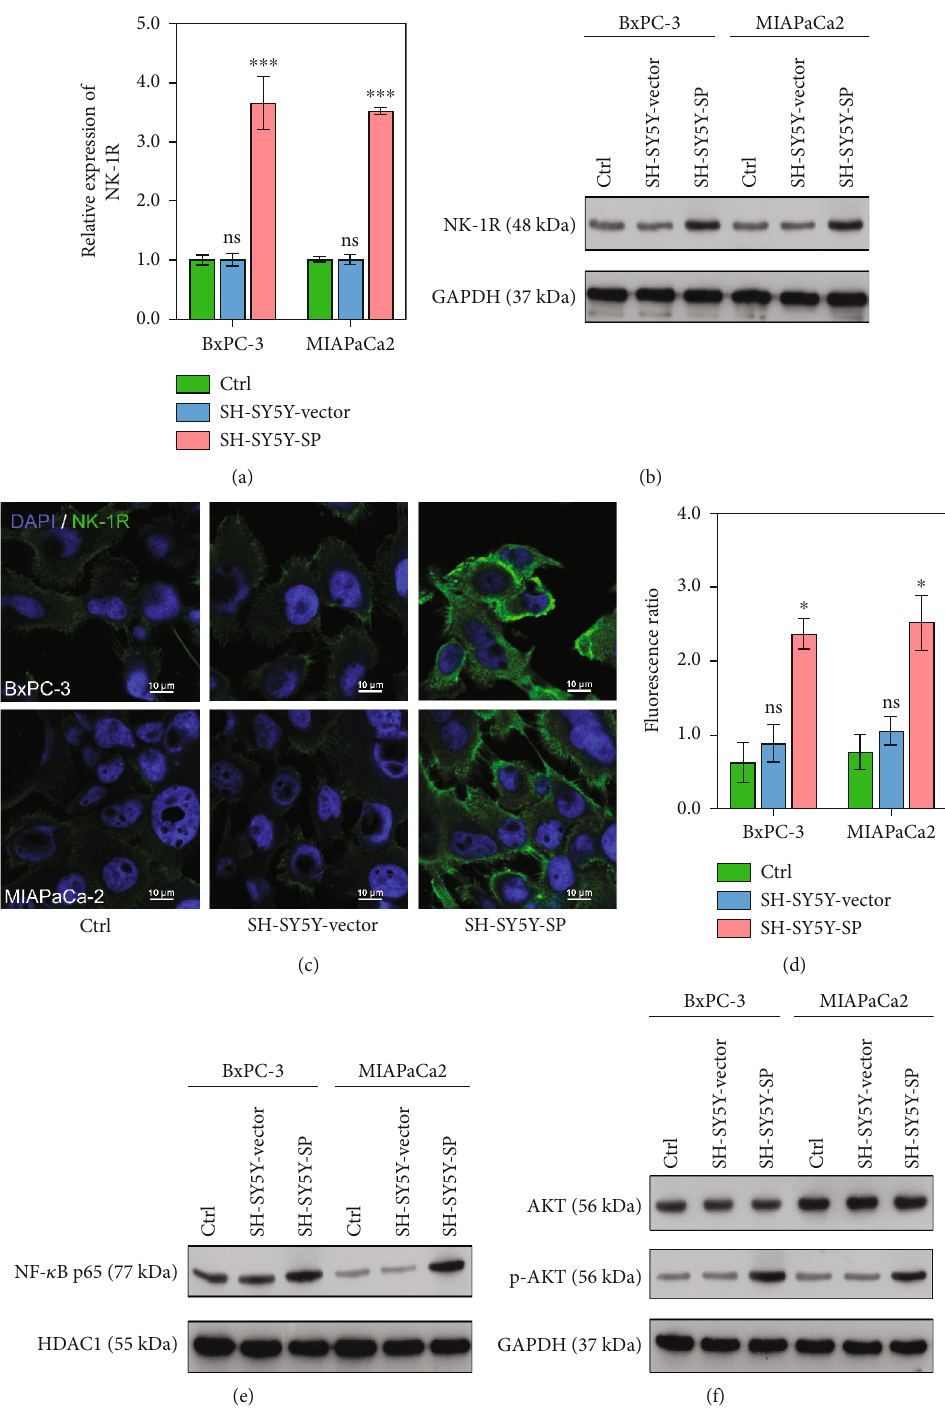
Figure 2: SP signi fi cantly increased the levels of NK-1R, NF- κ B p65, and p-AKT expression. (a – d) The levels of NK-1R expression were assessed using the qRT-PCR, western blotting, and IF. (e) The levels of NF- κ B p65 protein expression were evaluated using HDAC1 as a reference. (f) The levels of AKT and p-AKT proteins were evaluated using GAPDH as a reference. ns: no signi fi cant di ff erence, ∗ P < 0 : 05 , ∗∗∗ P < 0 : 001 vs. SH-SY5Y-Vector